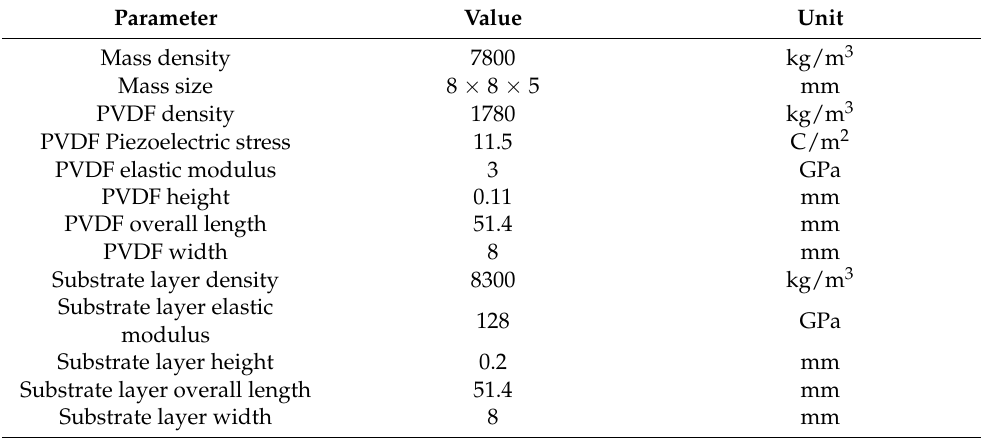
Table 1. Material parameters for simulation.